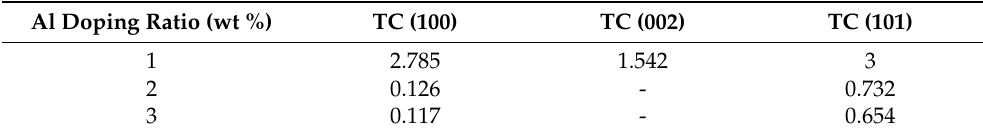
Table 3. Texture coefficient values of AZO films deposited with different Al ratios.